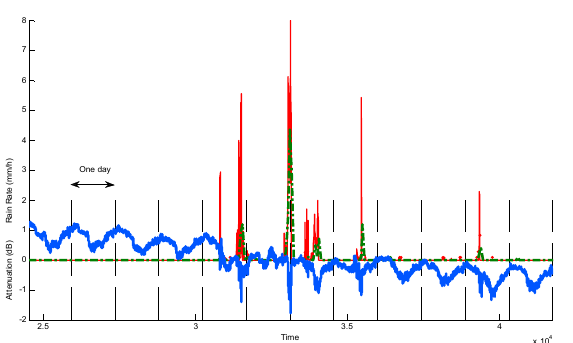
Fig. 5. Example of recorded time series: received signal (blue curve), radar rain rate (red curve) and 1h accumulated rainfall time series (dashed green curve).